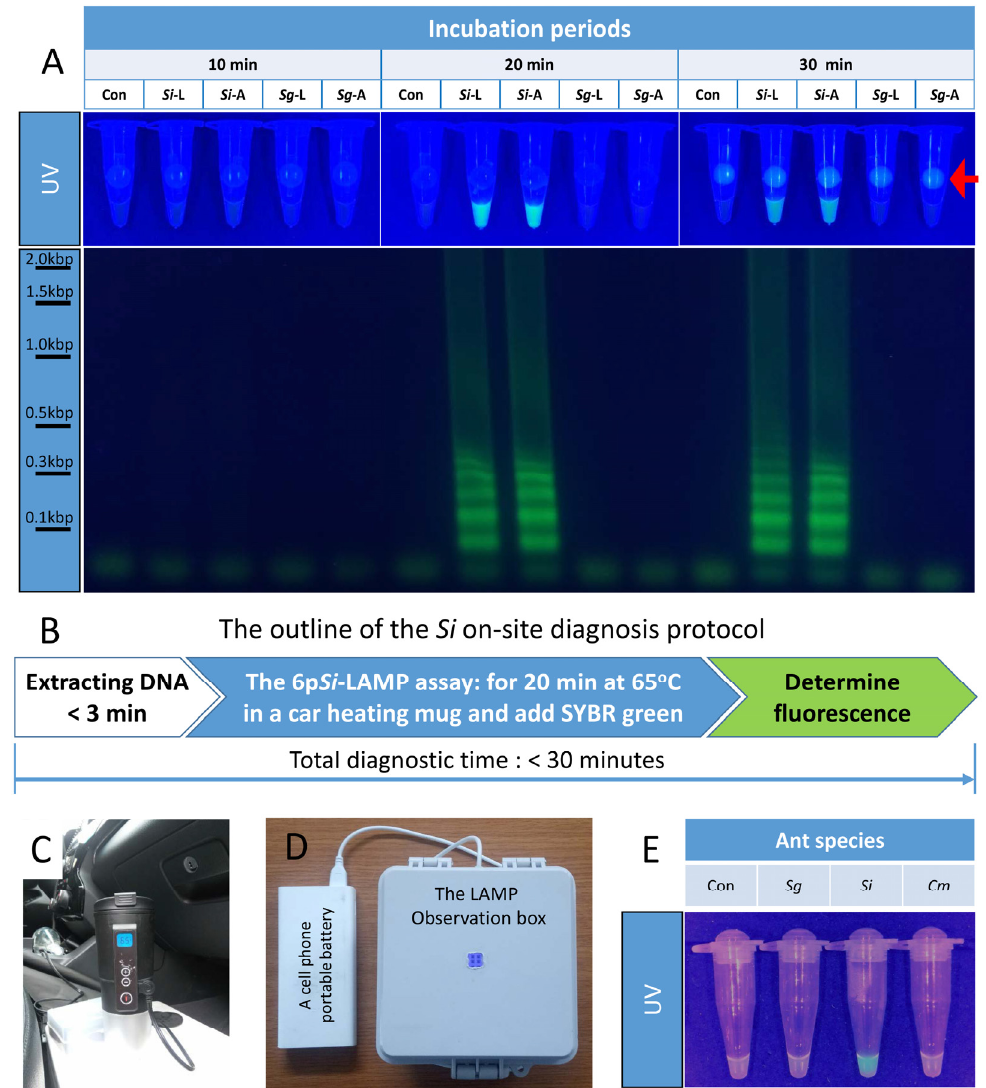
Figure 3. Determination of incubation times for 6p Si -LAMP assays and establishment of the Si on-site diagnosis protocol. ( A ) When genomic DNA from a leg (L) or an abdomen (A) of Si or Sg extracted with QGDES, respectively, was used for 6p Si -LAMP assays, strong fluorescence signals and ladder-shaped DNA bands were detected only from Si genomic DNA after 20 min. ( B ) The outline of the Si on-site diagnosis protocol. Si can be diagnosed in 30 min on-site. After genomic DNA from an abdomen of Sg , Si , or Cm extracted with QGDES for 3 min was mixed with a 6p Si -LAMP assay mixture at a 1:20 ratio, tubes were incubated for 20 min in a car heating mug ( C ). After adding SYBR green to each tube, fluorescence signals were detected in a LAMP observation box powered with a portable cell phone battery ( D ) and photographed with a cell phone ( E ). The red arrow indicated the fluorophore-delivering devices.